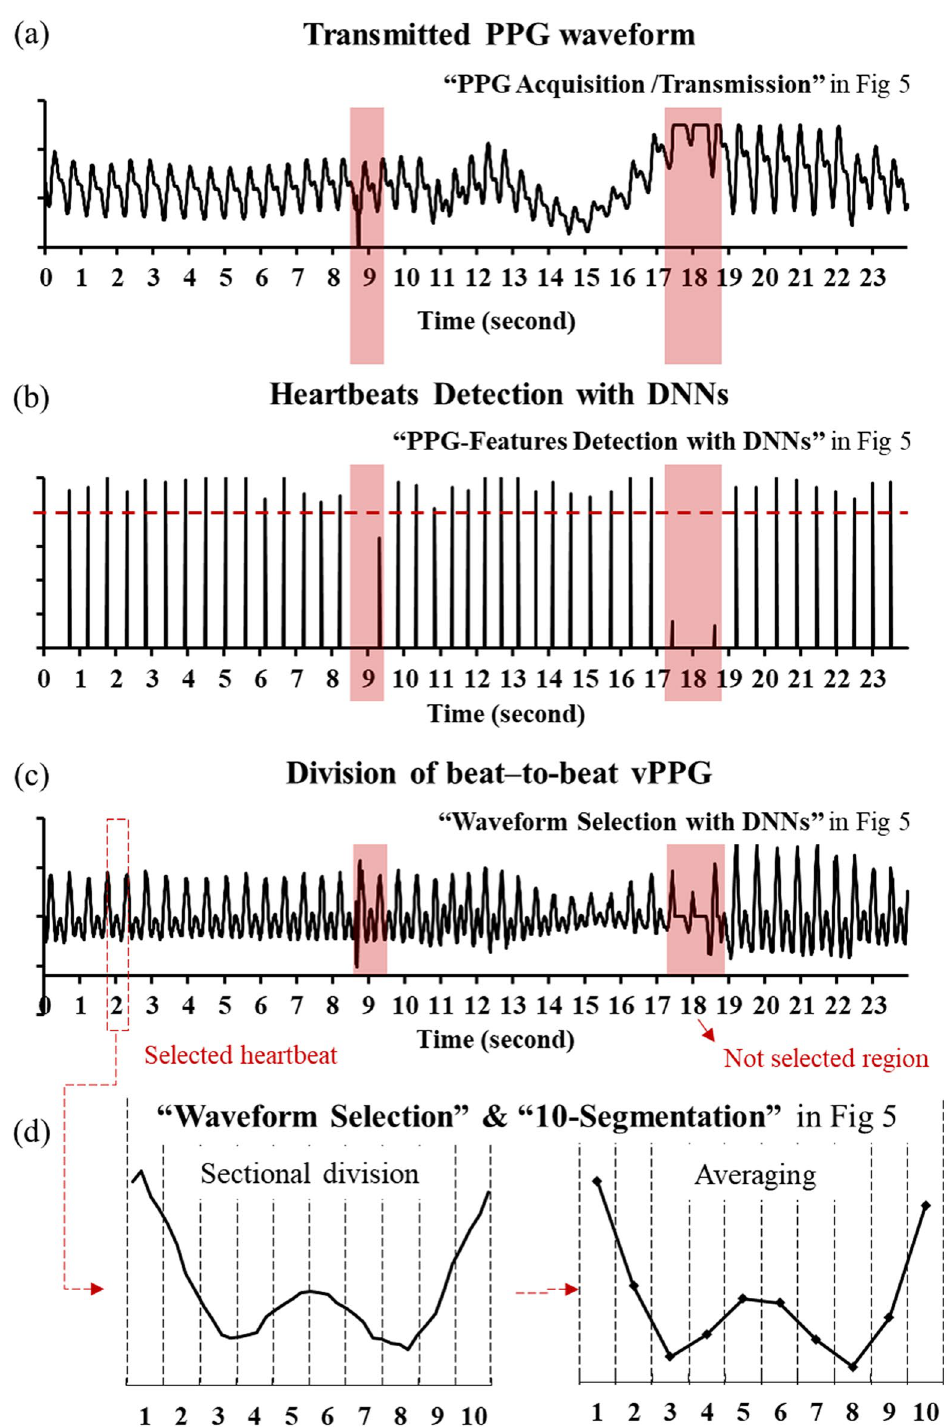
Figure 6. Data processing steps: ( a ) PPG data are transmitted; ( b ) Informative waveforms are selected using DNNs; ( c ) PPG waveforms are converted to the PPG velocity (vPPG) and divided for each heartbeat; and ( d ) Each waveform of vPPG is divided to 10-segment